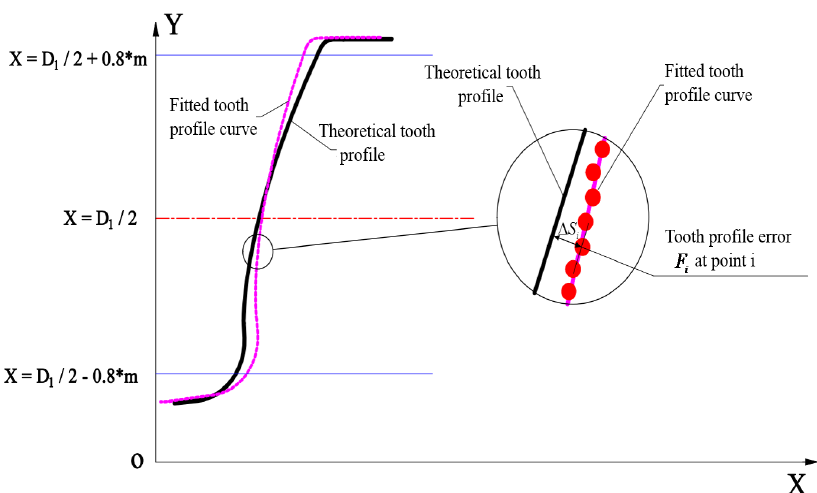
Figure 4. Schematic diagram of the tooth profile deviation calculation.